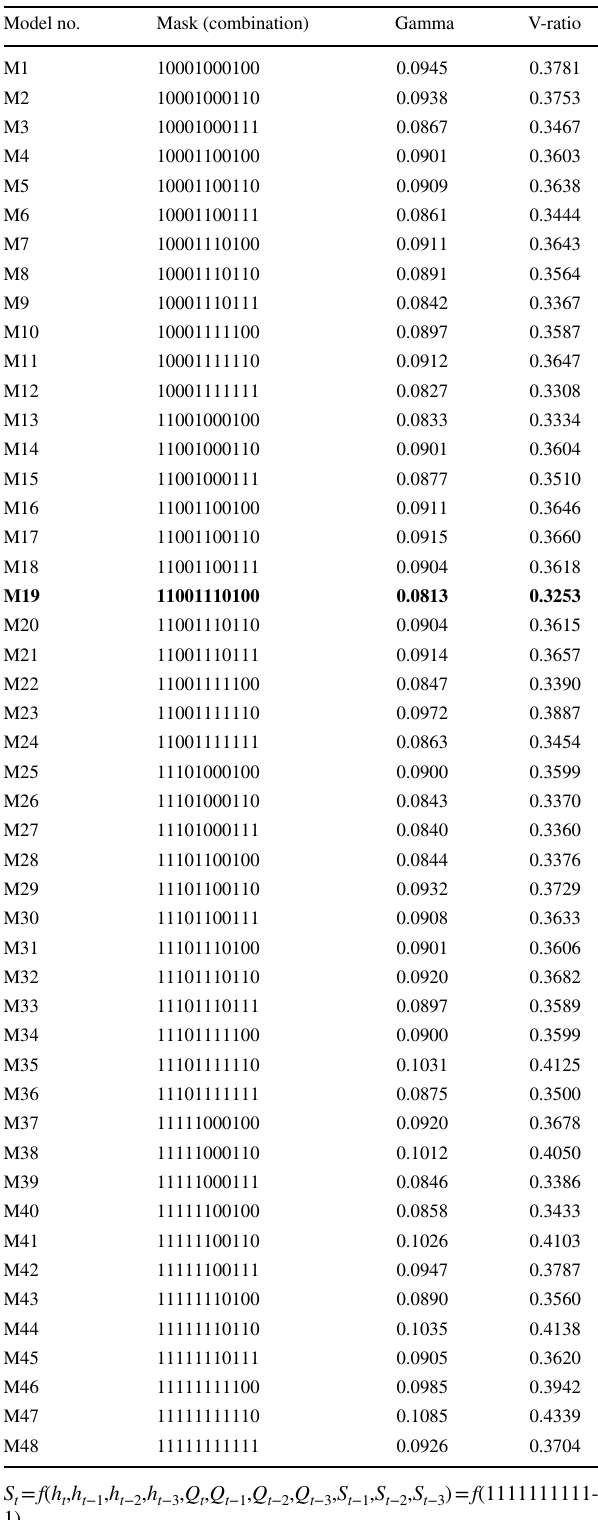
Table 3 Findings of the gamma test obtained for different combina- tions of input variables for the Adityapur site Model